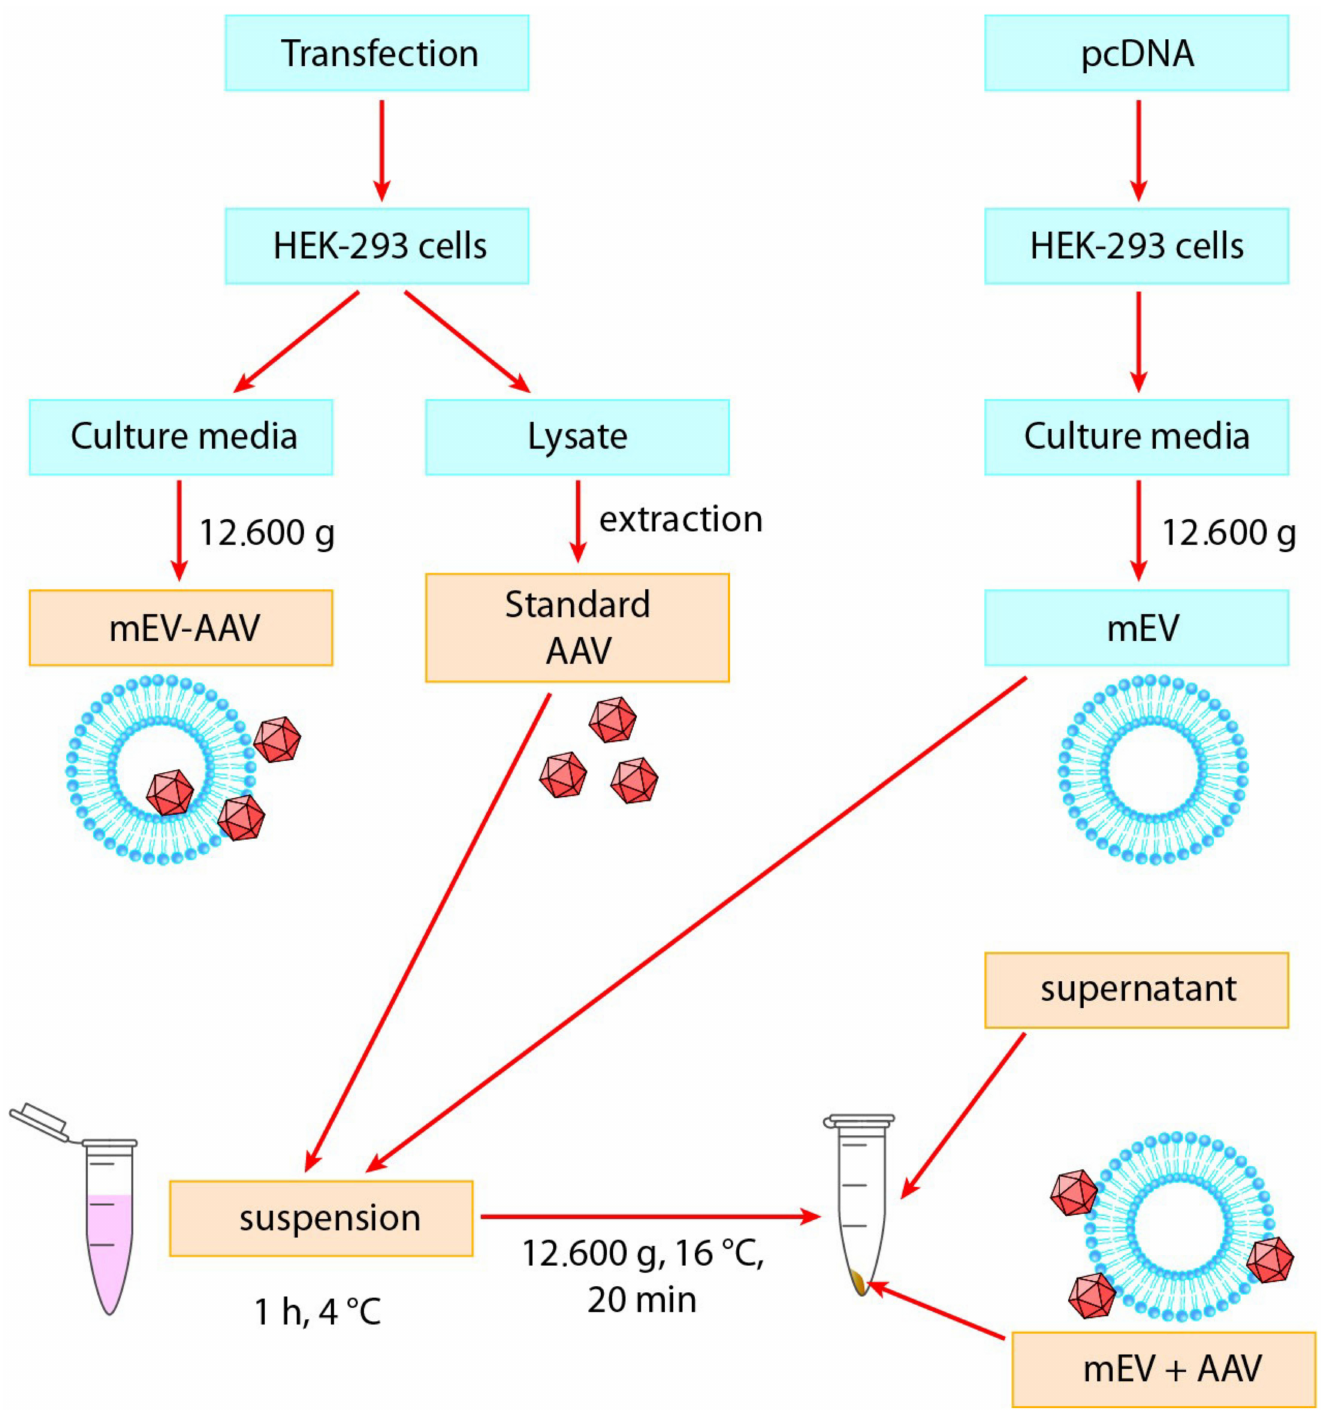
Figure 1. Experimental design of this study. Standard “AAV”, “mEV-AAV”, mEV and AAV “suspension”, “mEV + AAV”, and “supernatant” preparations were added to neuronal and primary astrocyte cell cultures (indicated with yellow). AAV: Adeno-associated virus, mEV-AAV: medium-sized extracellular vesicle-associated AAV, mEV + AAV: mixed mEV with